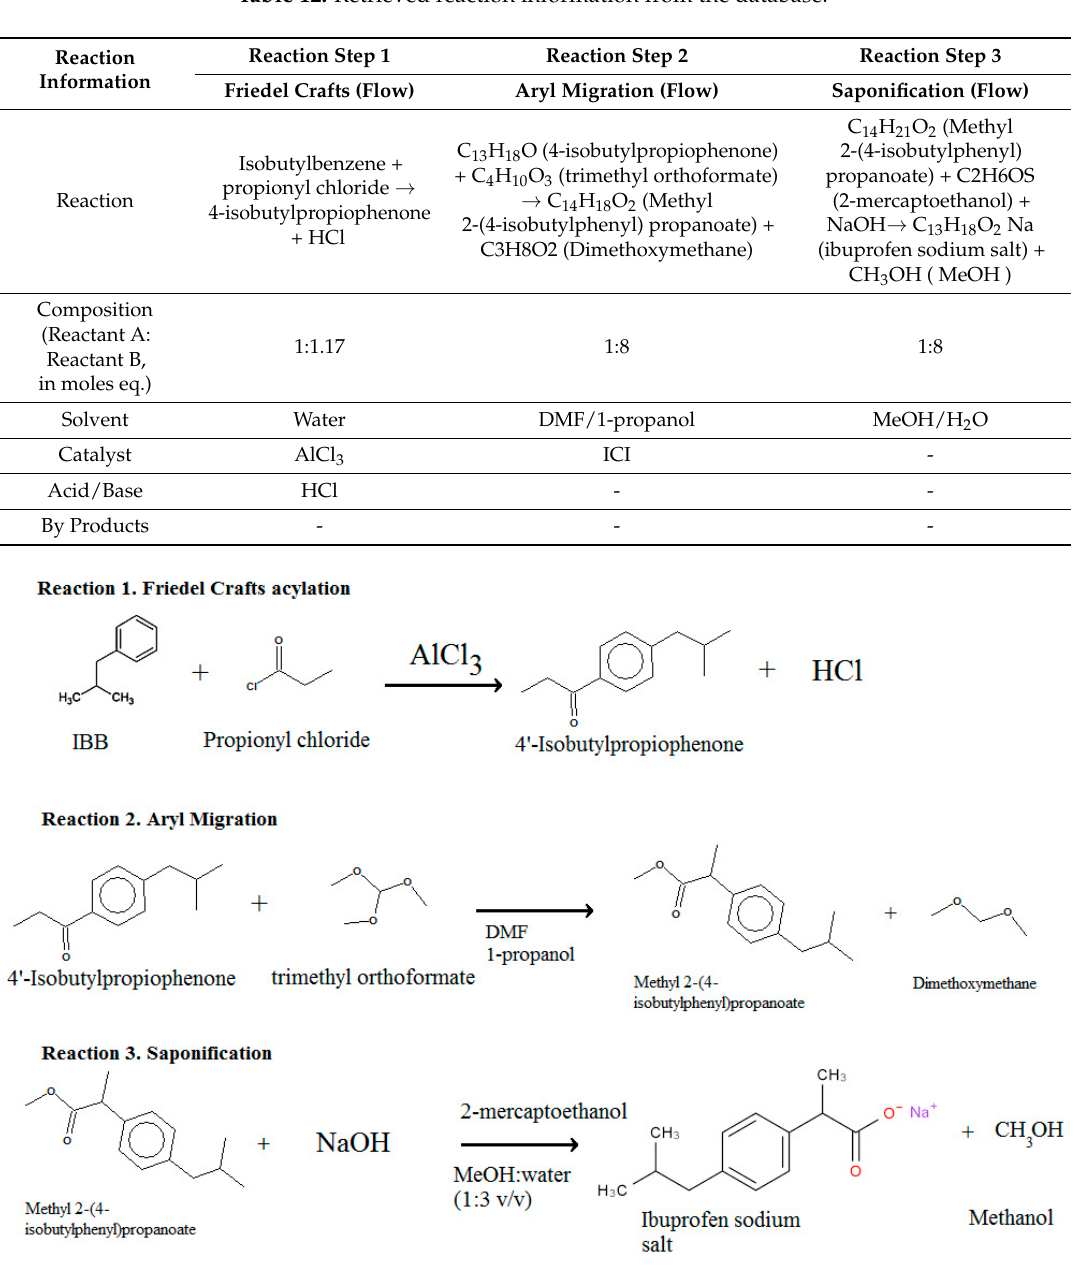
Figure 5. Reaction pathway proposed by Snead et al. for the continuous flow synthesis of ibuprofen.